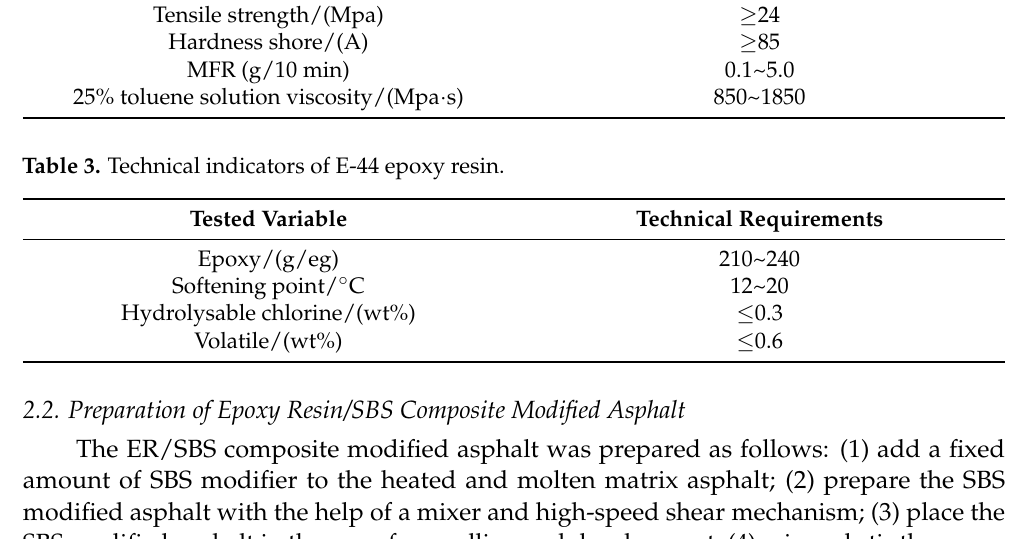
Table 2. Technical indicators of SBSYH-792E. Tested Variable